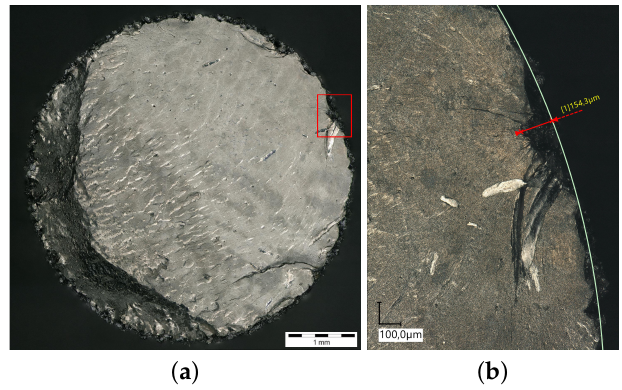
Figure 12. Fracture surface analysis for one specimen of the unprocessed condition. ( a ) Fractured surface of unprocessed as-built specimen. ( b ) Failure responsible surface